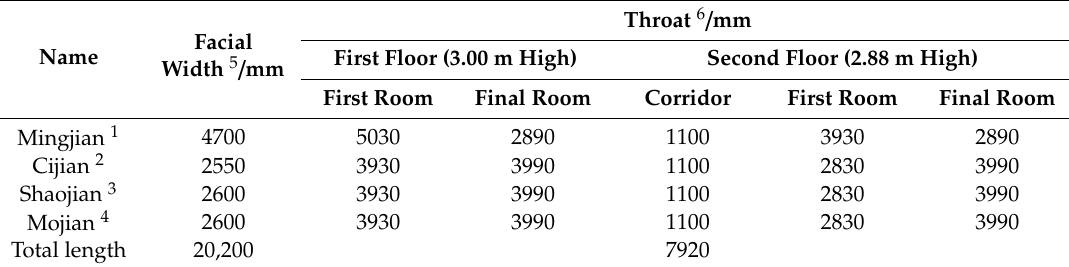
Table 1. The plane size of Seven Literary World.